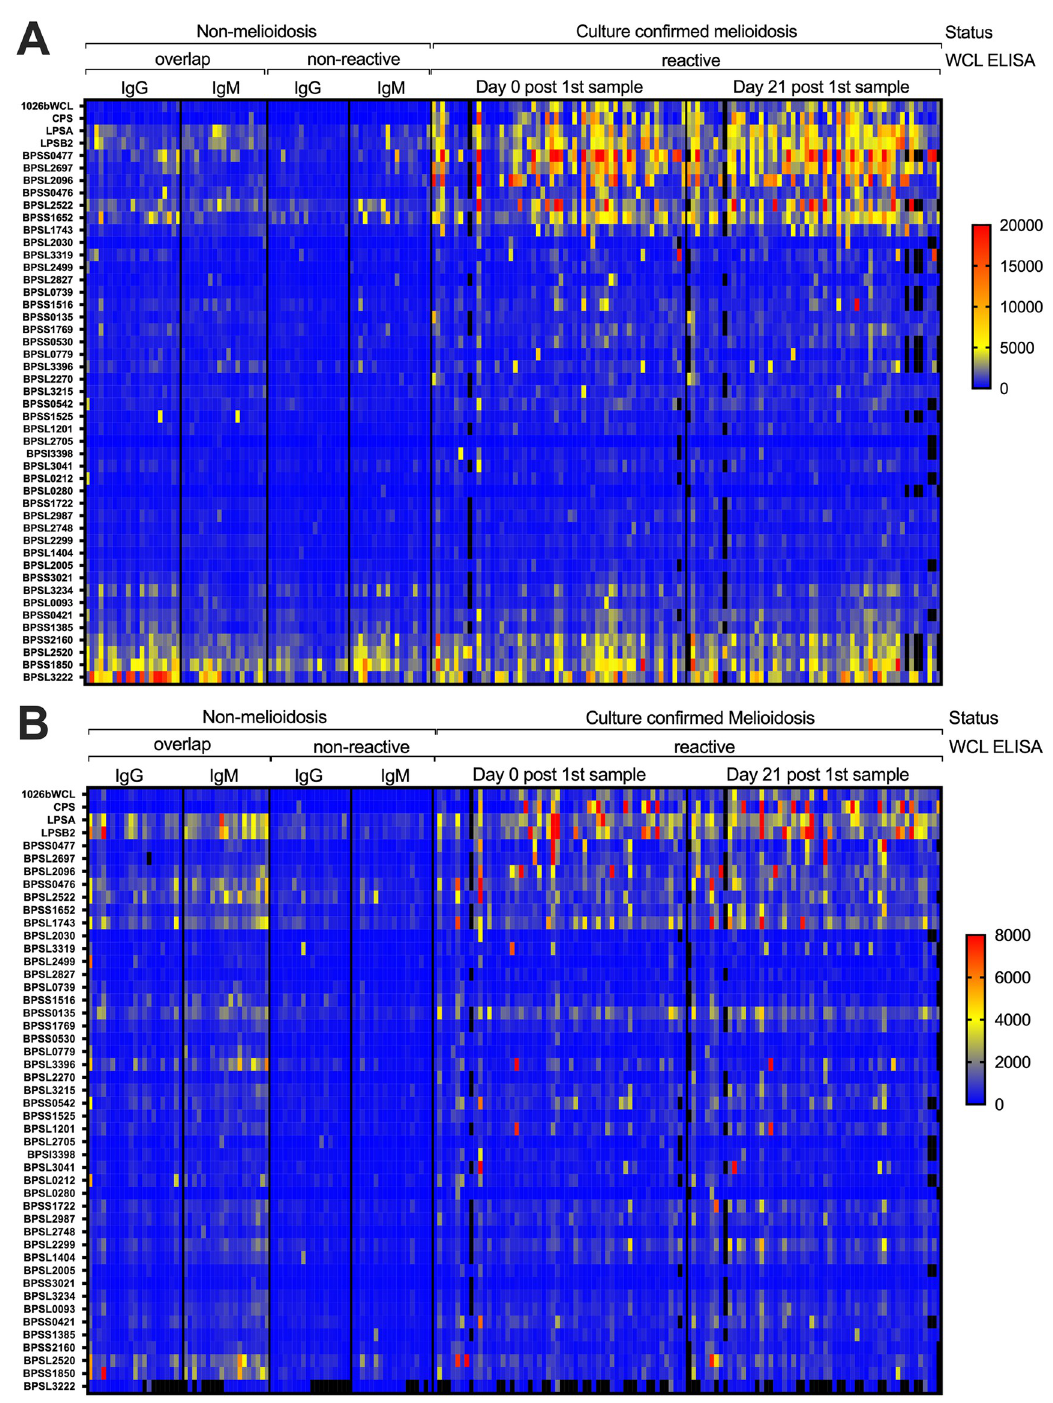
Fig 2. Heat map of MAGPIX multiplexed assay for IgG (A) and IgM (B). Each row represents an individual antigen, and each column represents an individual serum sample (n = 188). The sera are stratified by non-melioidosis negative and melioidosis samples. The negative group is further stratified by the 1026b whole cell lysate (WCL) reactivity (overlap and non-reactive IgG and IgM). The melioidosis serum is grouped by the sample’s collection time after initial sample collection. For the heat map, blue indicates 0 median fluorescent intensity (MFI) for both panels. For IgG panel A, yellow indicates 5,000 MFI and red indicates > 20,000 MFI. For IgM panel B, yellow indicates 4,000 MFI and red indicates > 8,000 MFI. Black indicates samples where data was not